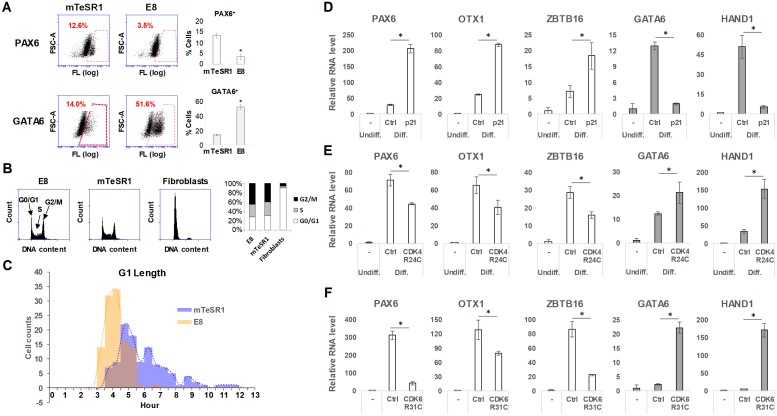
Single-cell distribution patterns of absolute G1 length determine differentiation propensity of hESC populations.(A) Immunoflow cytometry of PAX6 and GATA6 in H9 cells differentiated for 8 d by FGF2 deprivation (n = 4). (B) Propidium iodide staining analysis of H9 cells either in E8 or in mTeSR1 media and human dermal fibroblasts (n = 4 for E8 and mTeSR1, n = 3 for fibroblasts). (C) Histograms for G1 length of H9 cells grown either in E8 or in mTeSR1 (n = 112 for E8 and n = 114 for mTeSR1 pooled from three independent experiments); U test: p-value < 2.2 × 10−16, KS test: p-value < 2.2 × 10−16. (D-F) qPCR analysis of lineage markers in differentiated day 8 H9 cells overexpressing p21 (D), CDK4R24C (E), or CDK6R31C (F) (n = 4). Ctrl represents cells transduced with empty lentiviral vectors and treated with the same dose of doxycycline (1 μg/ml). Transgene expression was turned off at the onset of differentiation by doxycycline withdrawal. Error bars represent SD. *p < 0.01 (Student t test). Underlying data can be found in S1 Data. CDK, Cyclin-dependent kinase; Ctrl, control; Diff. differentiated; E8, Essential 8; FSC, forward scatter; FGF, Fibroblast growth factor; FL, fluorescence intensity; GATA6, GATA binding protein 6; HAND1, Heart and neural crest derivatives expressed 1; hESC, human embryonic stem cell; KS, Kolmogorov-Smirnov; OTX1, Orthodenticle homeobox 1; PAX6, Paired box 6; qPCR, quantitative PCR; Undiff., undifferentiated; ZBTB16, Zinc finger and BTB domain containing 16.